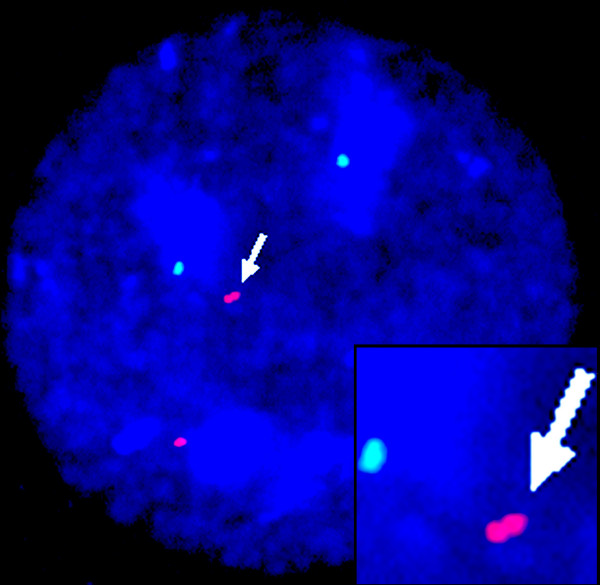
Fluorescence in situ hybridization (FISH) image of CNV14q12 (red) and RP11-79B13 (green), a control region on chromosome 14 that did not show a deviation from normal copy number according to the microarray comparative genomic hybridization experiments. The arrow marks the pair of FISH signals at CNV14q12. Quantitative-FISH showed that the marked probe was indeed due to hybridization at 2 adjacent loci rather than a split signal.